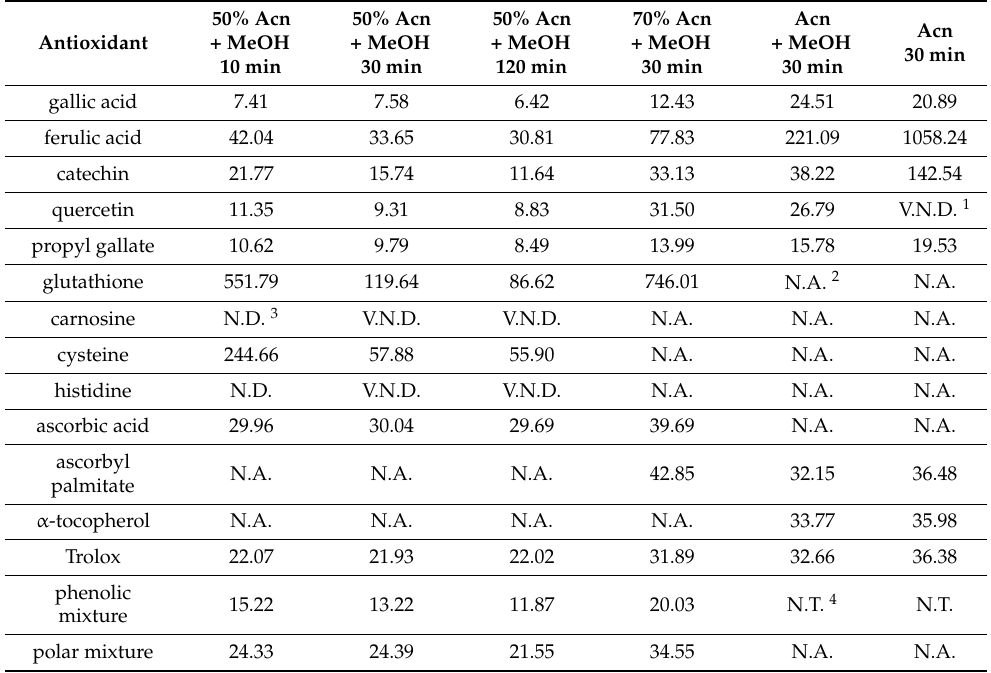
Table 6. IC 50 values ( µ M) determined against DPPH radicals applied in acetone or aqueous acetone after standard and modified reaction times (radical solution in methanol or acetone).